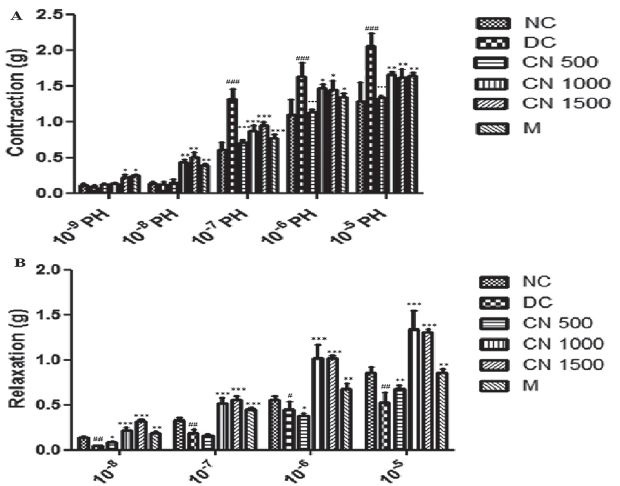
FIGURE 3 - (A) The contractile response of aortic rings to cumulative concentrations of phenylepherine (10-9 - 10-5 M) and (B) relaxation response of aortic rings to cumulative concentrations of Ach (10-8 - 10-5 M) in Normoglycemic Control (NC), Diabetes control group (DC), Cinnamomum cassia extract (CN 500, CN 1000, and CN 1500), and metformin (M) treated groups. Values are presented as means±SEM, * and # =p<0.05, ** and ## =p<0.01, *** and ### =p<0.001, (n = 10).